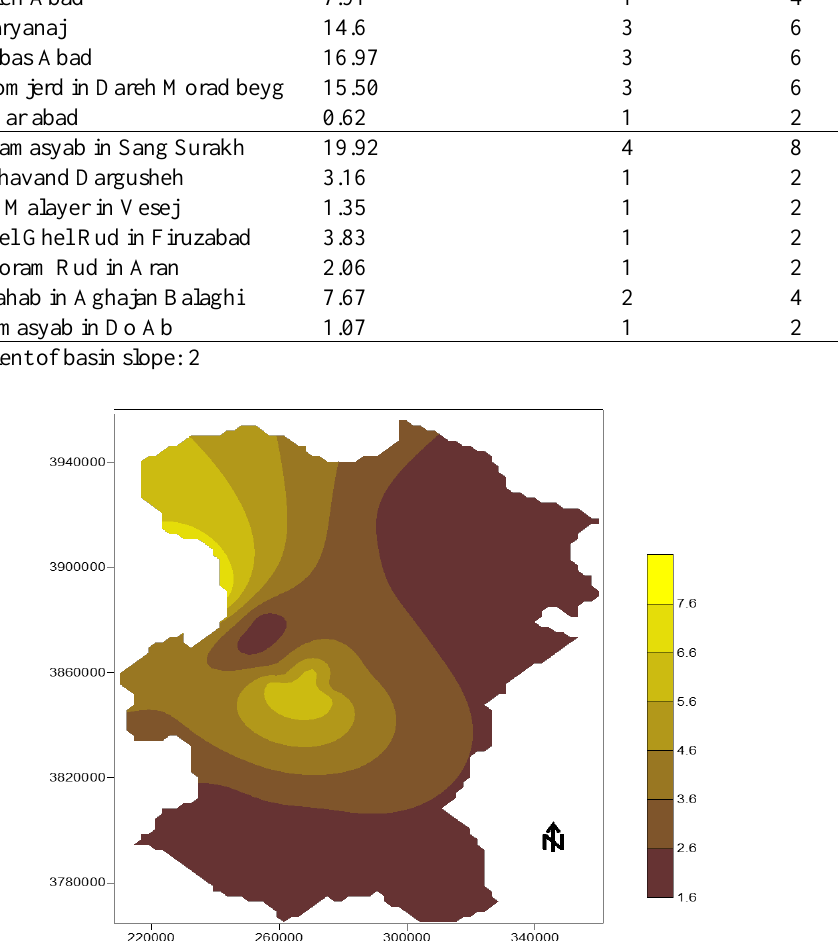
Average watershed slop (%)